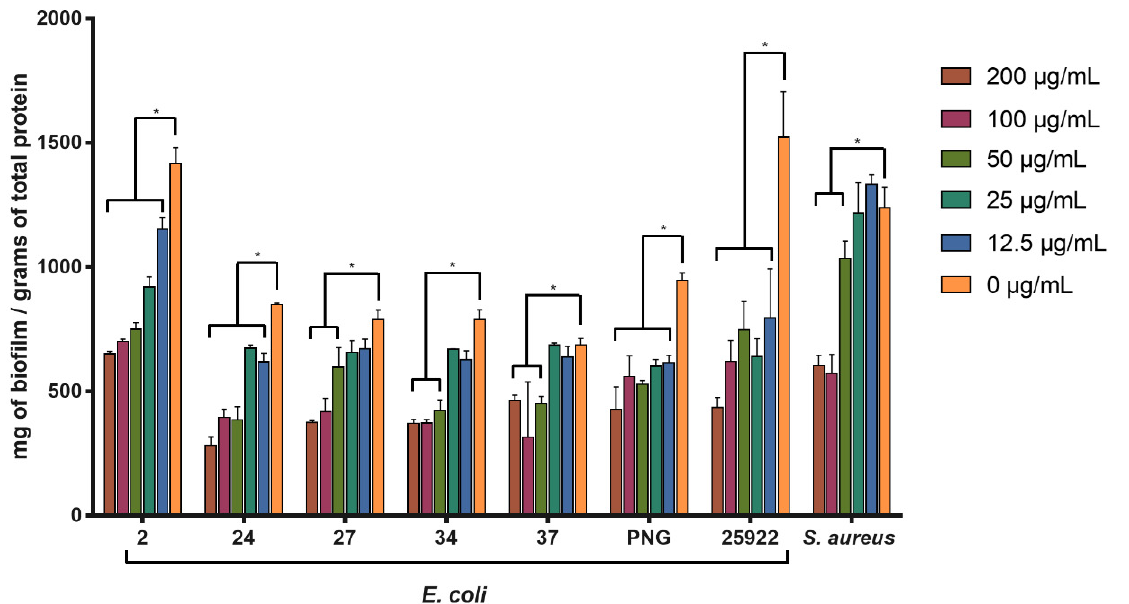
Figure 6. Antibiofilm activity of SPw-AgNPs against ATCC and clinical isolates of multi-drug resistant bacteria. Bacterial biofilms were tested with different doses of SPw-AgNPs (200–12.5 µ g/mL). Data represent the mean of three independent experiments ± standard deviation. * Statistical significance between treated and untreated biofilm ( p < 0.05).